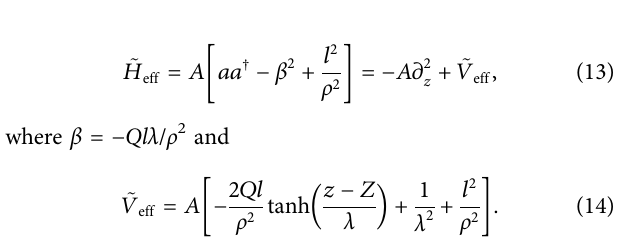
FIGURE 2 | Schematic illustrations of magnon trajectory on the ferromagnetic nanotube in the presence of the Skyrmion-textured domain wall. The red and blue regions represent the domains whose background magnetizations are m 0 (cid:1) − ^ z and m 0 (cid:1) ^ z , respectively. The green arrows perpendicular to the surface express the emergent magnetic fi eld associated with the Skyrmion charge (A) Q = 1 and (B) Q = − 1. The white curves indicate the trajectories of magnons.